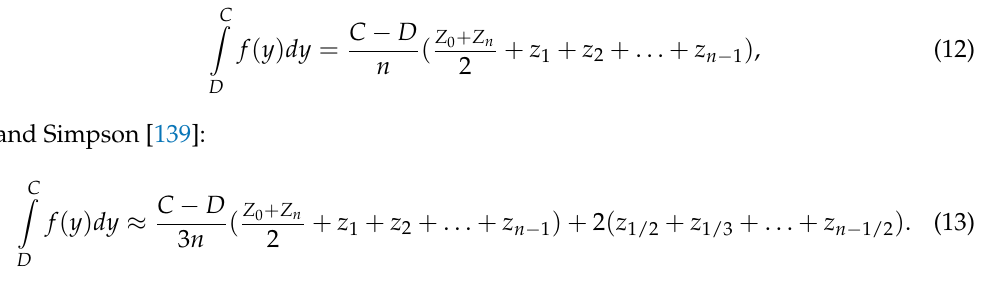
Figure 8 shows an example of a modeling object vertical section with the indicated key parameters, which are taken into account when calculating the area and subsequent volume determination.